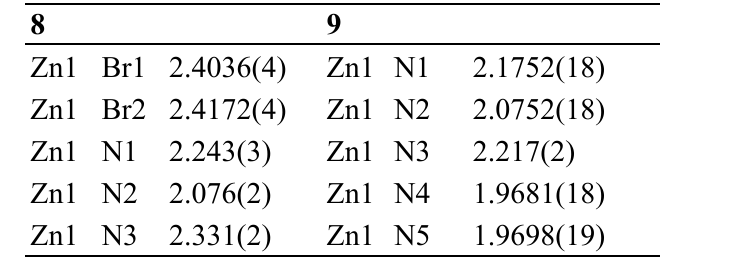
Table 1. Selected bond lengths [ Ǻ ] and Selected bond angles [°] for compounds 8 and 9